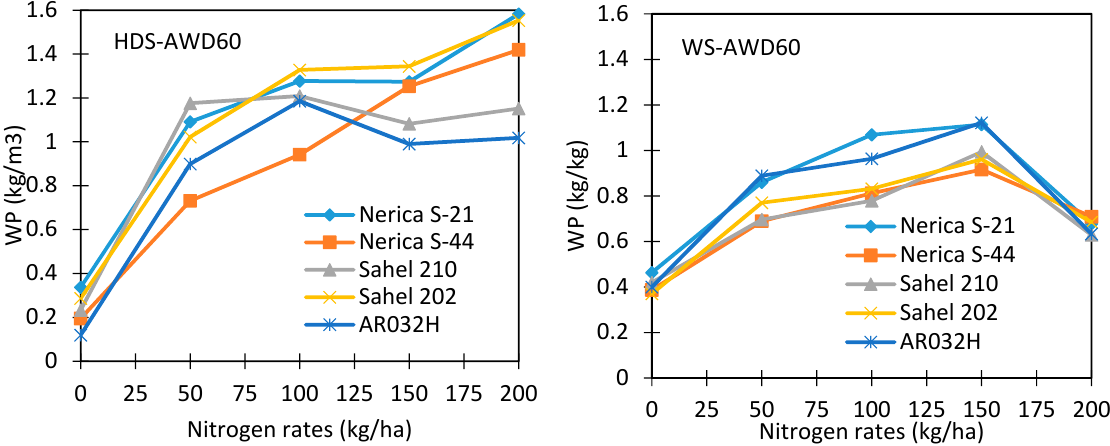
Figure 8. Variation in water productivity (WP) of five rice genotypes as function of applied nitrogen fertilizer rates.